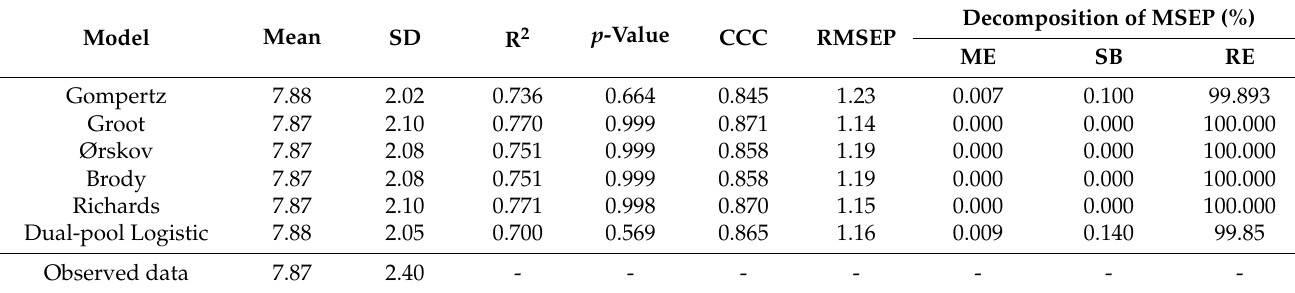
Table 3. Evaluation of models fitting to estimate the in vitro gas production of corn silage combined with feed additives.